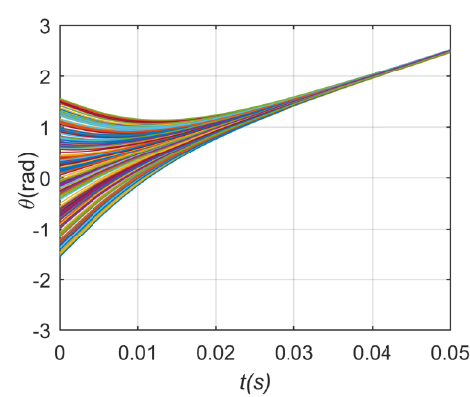
Figure 8. Phase stabilization process of directed network in case